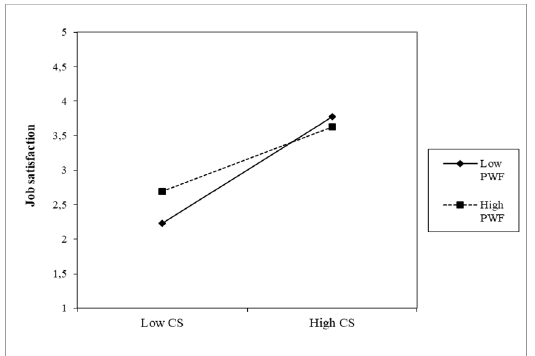
Figure 6. Moderating effect of PWF on the CS–JS relationship.